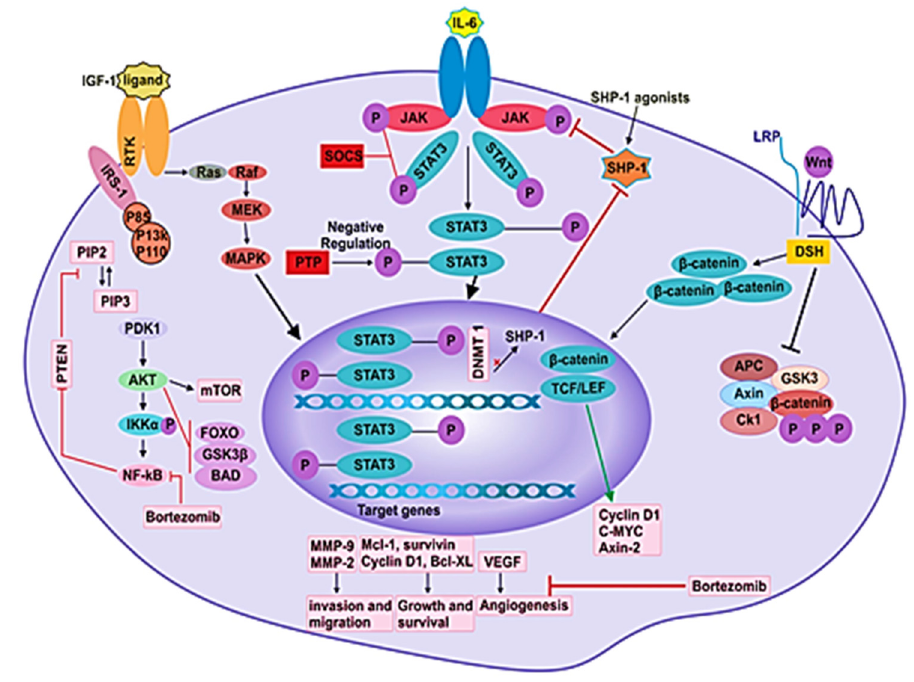
Figure 3. Di ff erent signaling pathways in MM pathogenesis. Signaling pathways such as JAK / STAT, PI3K / Akt, NF-kB, Ras / Raf / MEK / Erk and Wnt / β -catenin participate in the pathogenesis of disease Figure 3. Different signaling pathways in MM pathogenesis. Signaling pathways such as JAK/STAT, PI3K/Akt, NF-kB, Ras/Raf/MEK/Erk and Wnt/ β -catenin participate in the pathogenesis of disease by mediating the angiogenesis, proliferation, survival, differentiation, invasion and migration of MM cells.